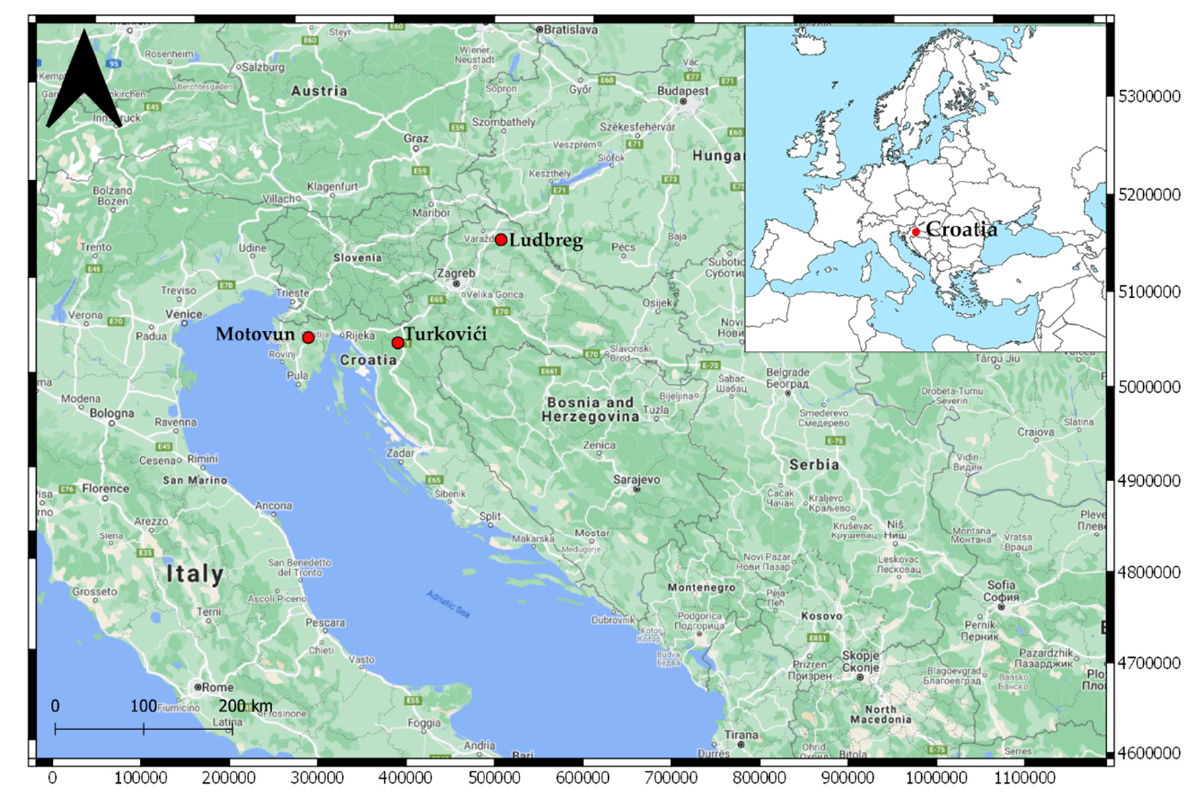
Figure 1. Locations of the analyzed rivers and hydrological measuring stations [17]. Each of the rivers flows through different geological, i.e., hydrogeological media, which definitely has an impact on the hydrological characteristics of the observed rivers. Table 1. Characteristics of the rivers Bednja, Gornja Dobra, and Mirna [18]. River Length (km) Max Flow (m 3 /s) Bednja